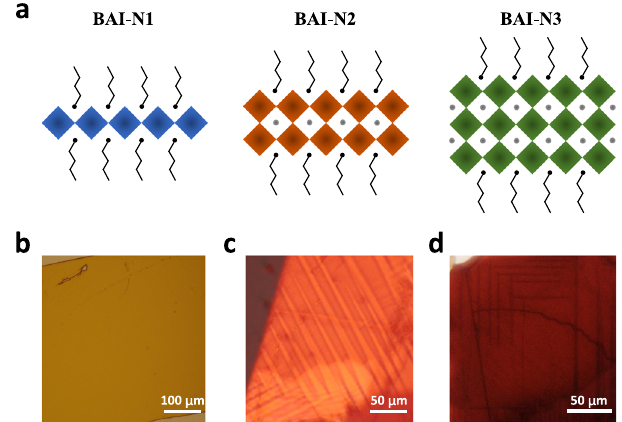
Fig. 2 Layer number dependent ferroelasticity in layered perovskites. a Scheme of crystal structures for BAI-N1, BAI-N2, and BAI-N3; b – d corresponding polarized optical microscope images for BAI-N1, BAI-N2, and BAI-N3,